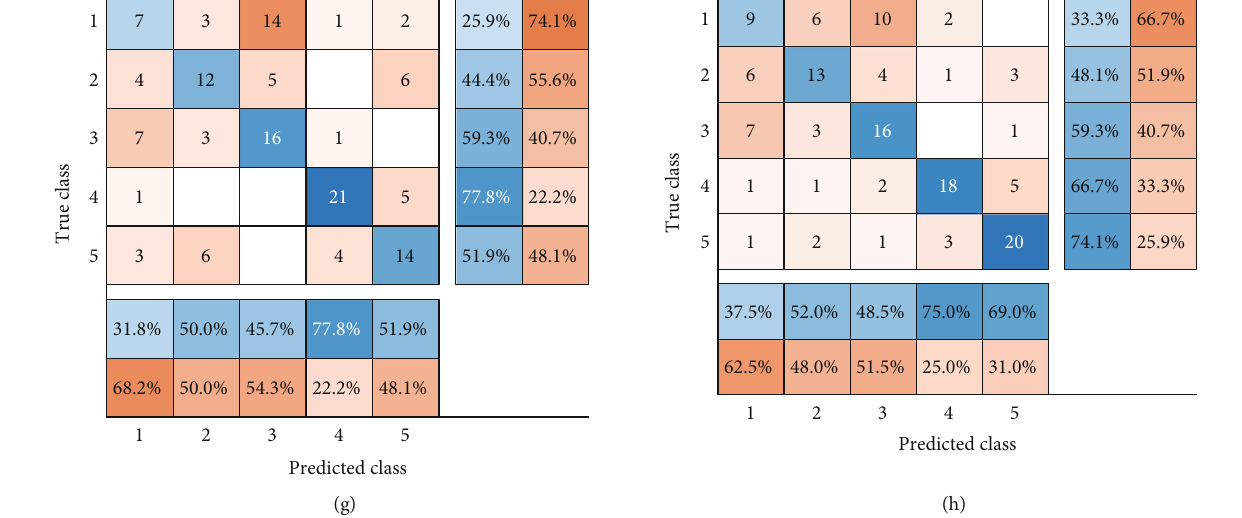
In Figures 17(a) – 17(h), the abscissa indicates the pre- dicted value, the ordinate indicates the true value, and the value on the diagonal line indicates the number of correct classi fi cation result.